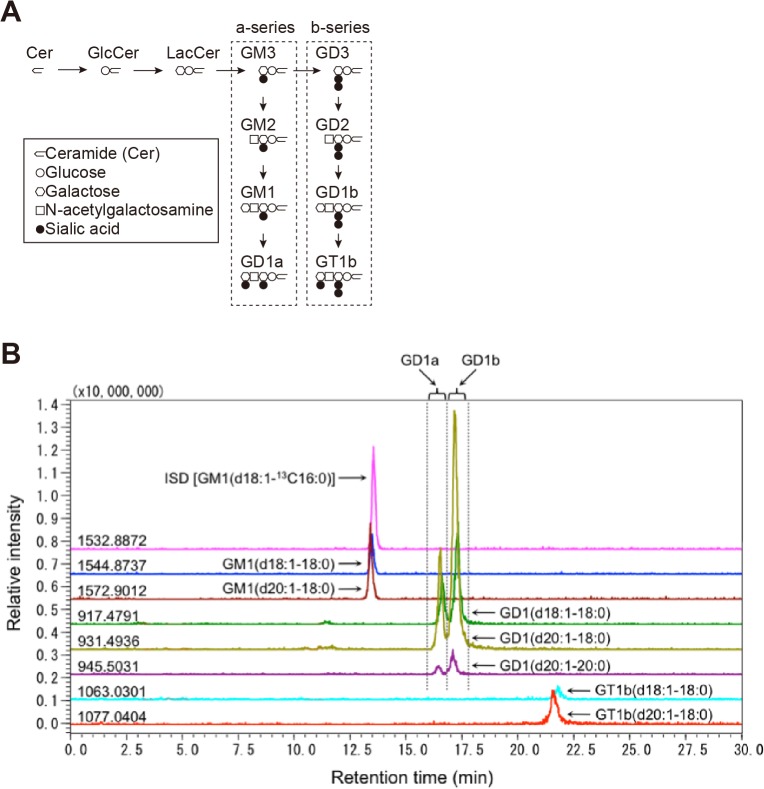
Analyses of gangliosides by normal-phase LC-MS with regard to the glycan structure of gangliosides.A, Scheme of synthesis pathway of a- and b-series of gangliosides. B, Representative chromatograms of normal-phase LC-MS of gangliosides using an NH2 column. GM1(d18:1–13C16:0) [m/z 1532.88 (shown on the left side on the chromatogram)] was used as ISD. In this system, a-series (GD1a) and b-series (GD1b) GD1-gangliosides were separately detected on the basis of the diversity of the glycan structure. The expression level of each ganglioside species was calculated by measuring each peak area above the baseline.